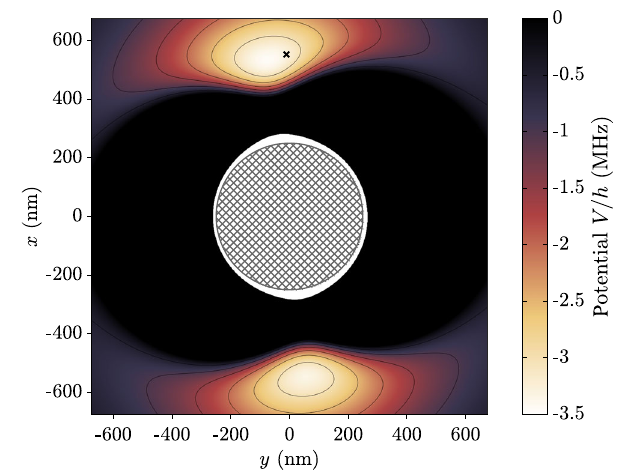
FIG. 7. Potential V 0 ð r Þ þ 2 β γ Re g st γ ð r Þ perturbed by strain